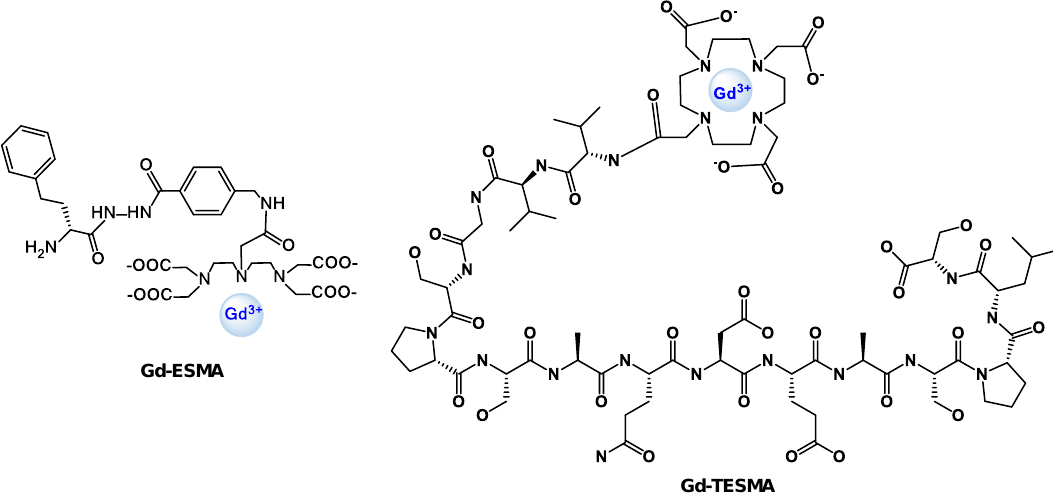
Scheme 2. Chemical structures of MRI agents designed for elastin and tropoelastin